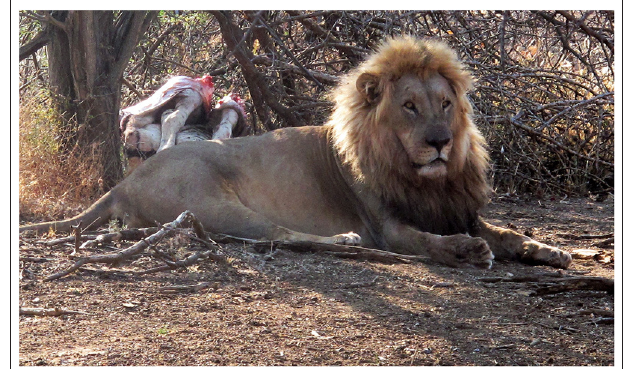
FIGURE 9 | Lion with zebra carcass, Waterberg Plateau Park,